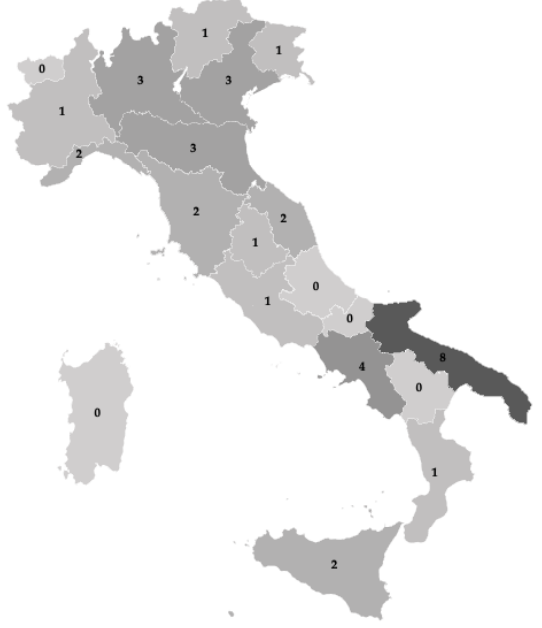
Figure 2. Number of occupational heat-related illnesses and injuries as reported by Italian online newspapers in the years 2020 to 2022, by region.